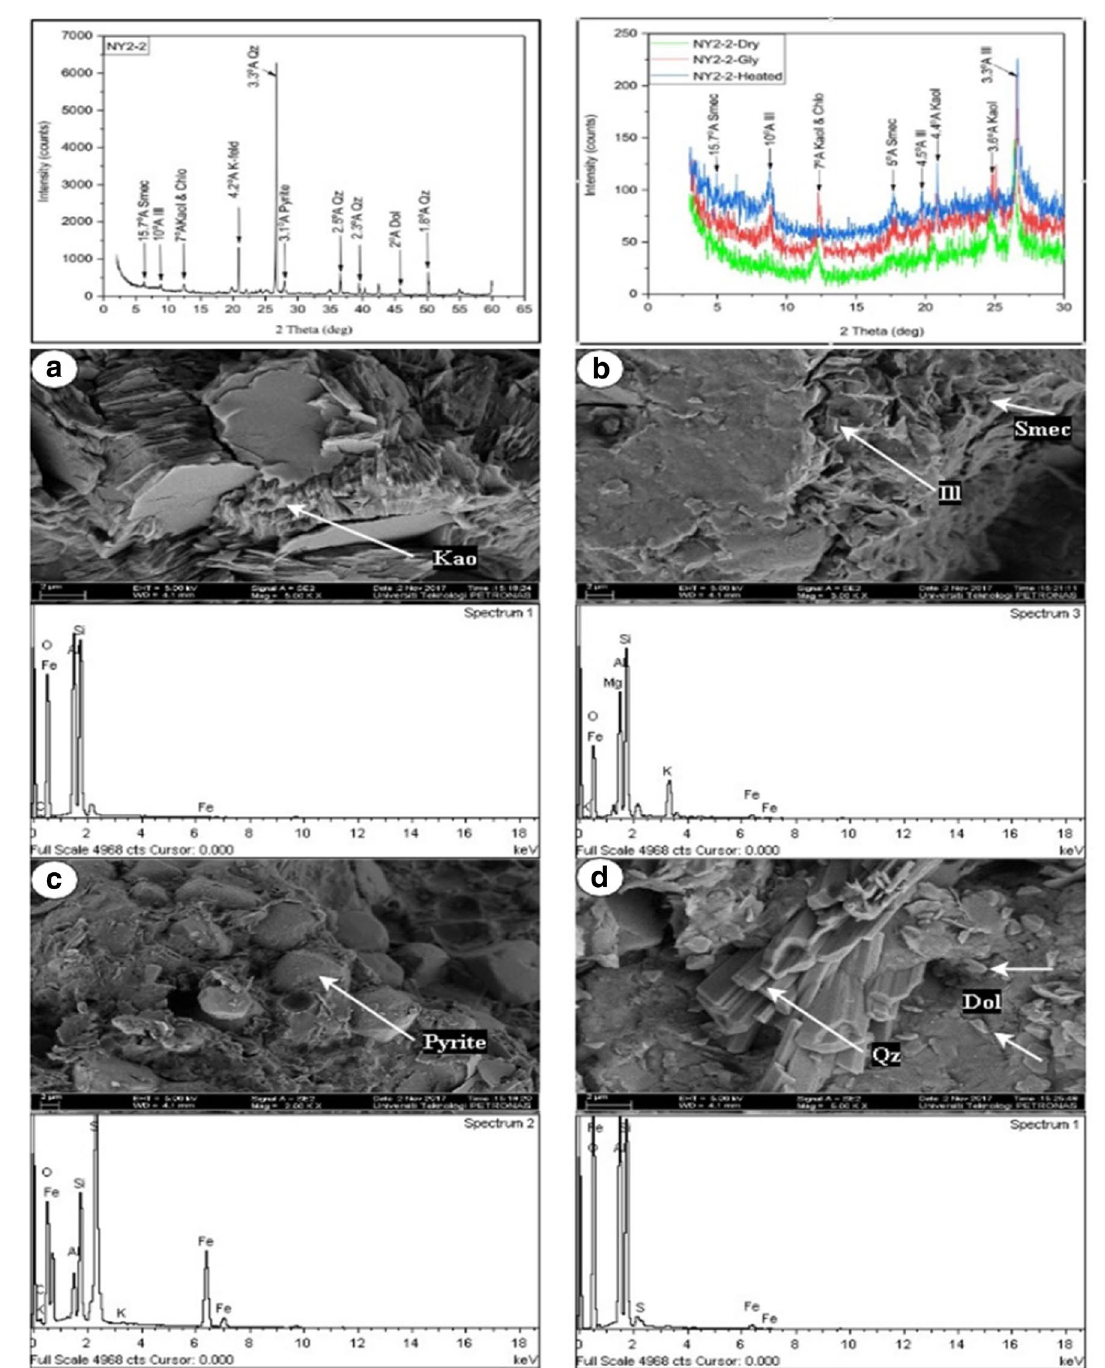
Fig. 3 XRD, XRD clay separation and FESEM micrograph for Nya- lau Formation showing the main mineral components in the shale and mudstone samples and their energy-dispersive X-ray (EDX) spec-